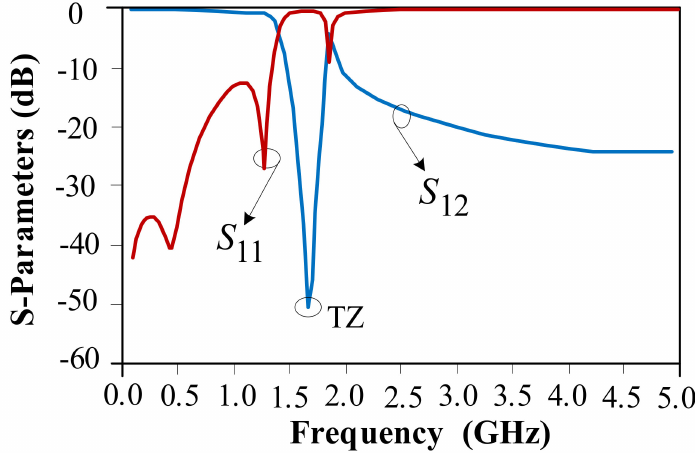
Figure 6. The S 11 and S 12 magnitudes in decibels versus frequency. The extracted LCE model has an asymmetrical structure, where the obtained values for the applied lumped reactive elements are listed in Table